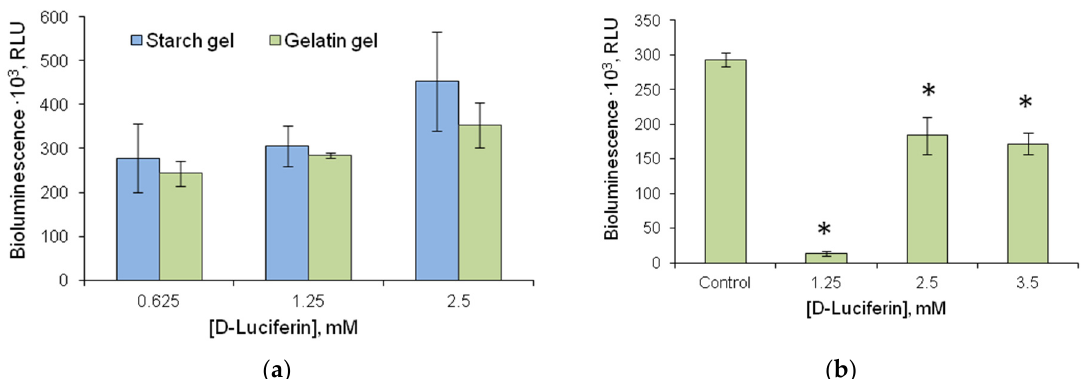
Figure 7. Luminescence intensity of reagents of different compositions based on the firefly luciferin- luciferase system: ( a ) Luminescence intensity of FLuc in the presence of immobilized D-luciferin (FLuc was added to the reaction mixture in the form of the solution; reaction was started by adding 20 µ L of 50 nM ATP solution); 3% starch gel and 1% gelatin gel were used for immobilization; ( b ) Luminescence intensity of multicomponent reagent containing 4.2 µ g of FLuc and various concen- trations of D-luciferin; reaction was started by adding 20 µ L of 50 nM ATP solution; 1% gelatin gel was used for immobilization. * p < 0.05 when comparing with the control.